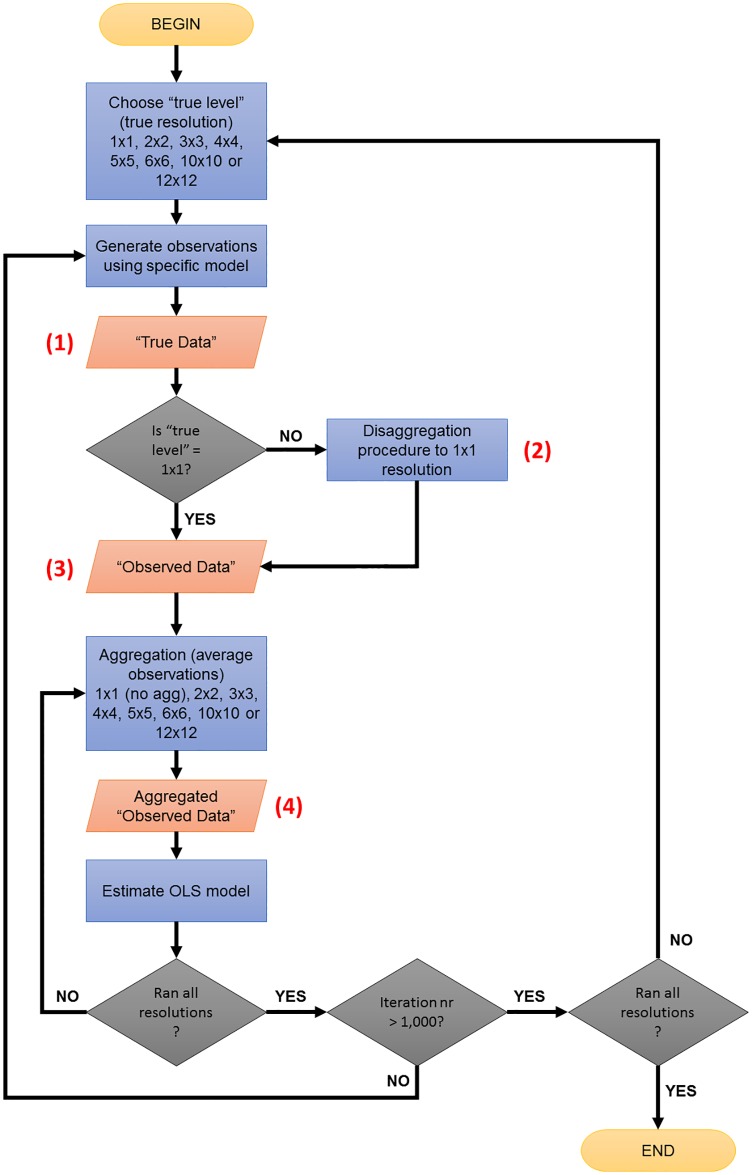
Monte Carlo Simulation Flow Chart.